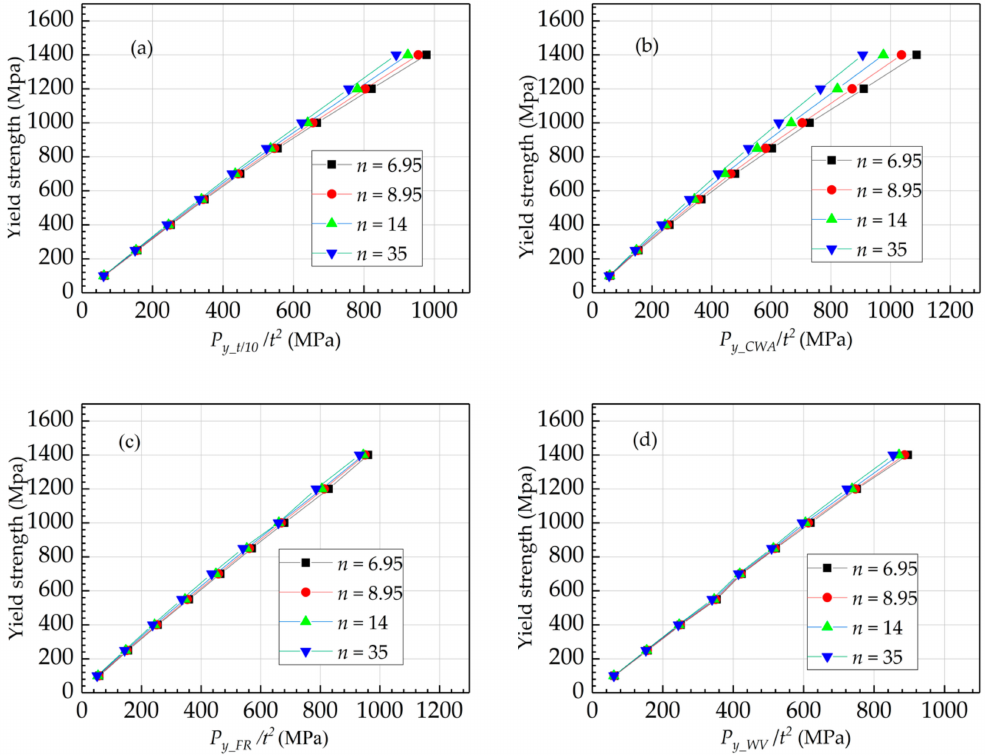
Figure11. Linearcorrelationofyieldloadsidentifiedbydi ff erentidentificationmethods: ( a ) t / 10method; ( b ) CWA method; ( c ) FR method; ( d ) WV method.